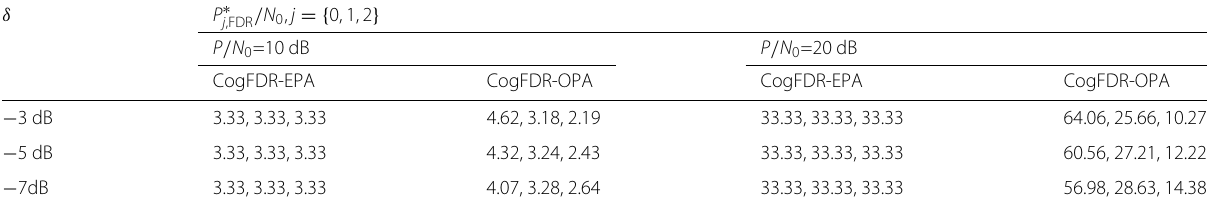
Table 1 Comparison of power allocation schemes for various levels of IRI δ and total transmit power P / N 0